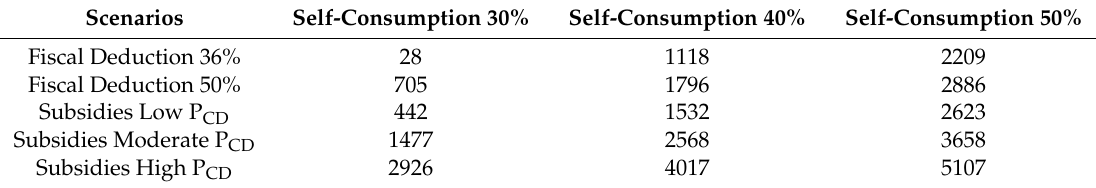
Table 11. NPV in alternative scenario (t r = 1600 kWh/m 2 × year). Data expressed in €